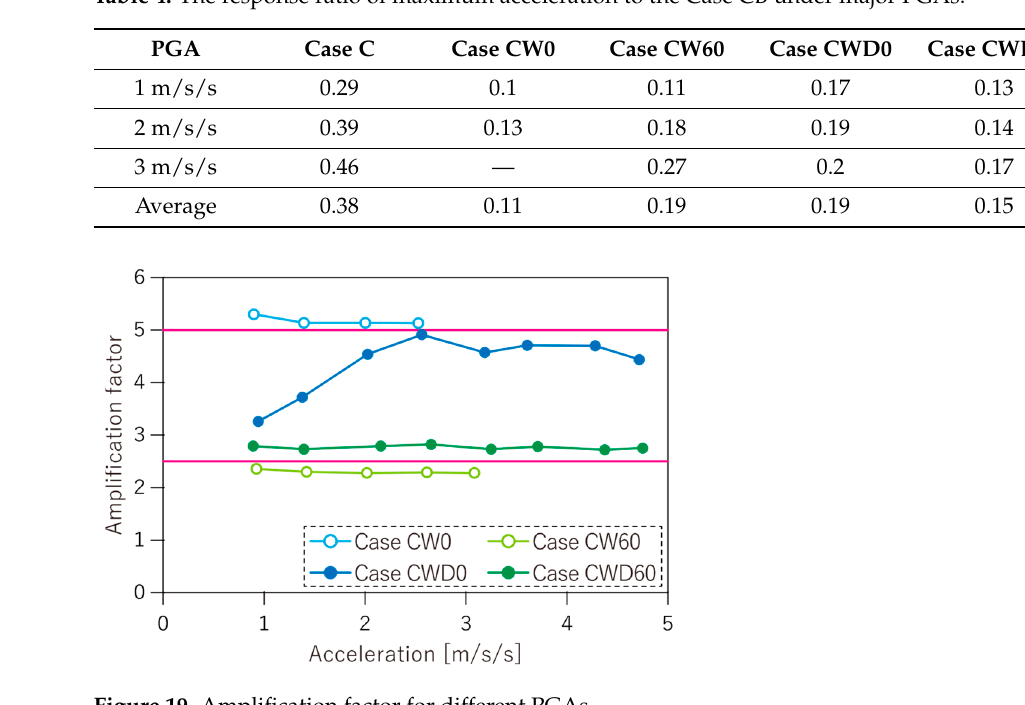
Figure 19. Amplification factor for different PGAs.